Question: Describe this figure in one sentence.
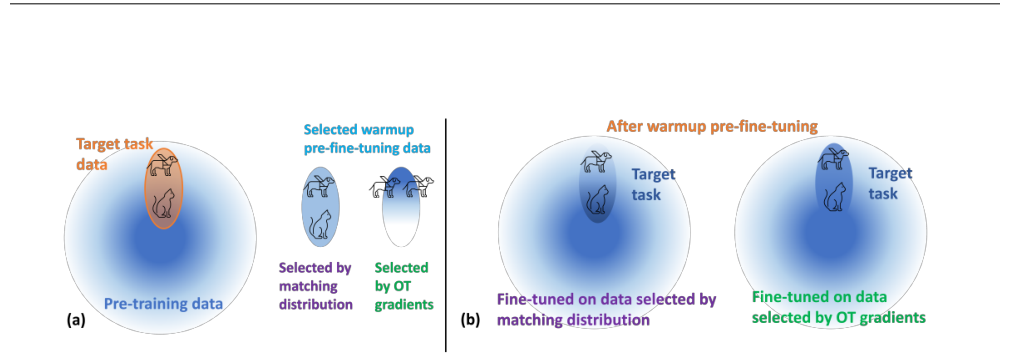
Answer: Consider an LLM pre-trained on a large corpus of 99% cat examples and 1% dog examples. The target task consists of 50% cat examples and 50% dog examples. The model’s relative lack of knowledge of dogs will be its performance bottleneck on the target task. Before deploying the LLM on the target task, we select samples from the pool of available data to perform lightweight warmup pre-fine-tuning to better prepare the model for the target task knowledge. Selecting data by matching distribution to the target task will end up selecting 50% cat and 50% dog examples, where only the 50% dog examples will help. In low data regimes where the fine-tuning data is considerably small, this further loss of data efficiency prevents the model from achieving the best possible performance improvements. Our gradient-based selection will select 100% dog examples, which best help the model to make up for the knowledge it lacks. In this case, our approach is able to double the data efficiency in fi